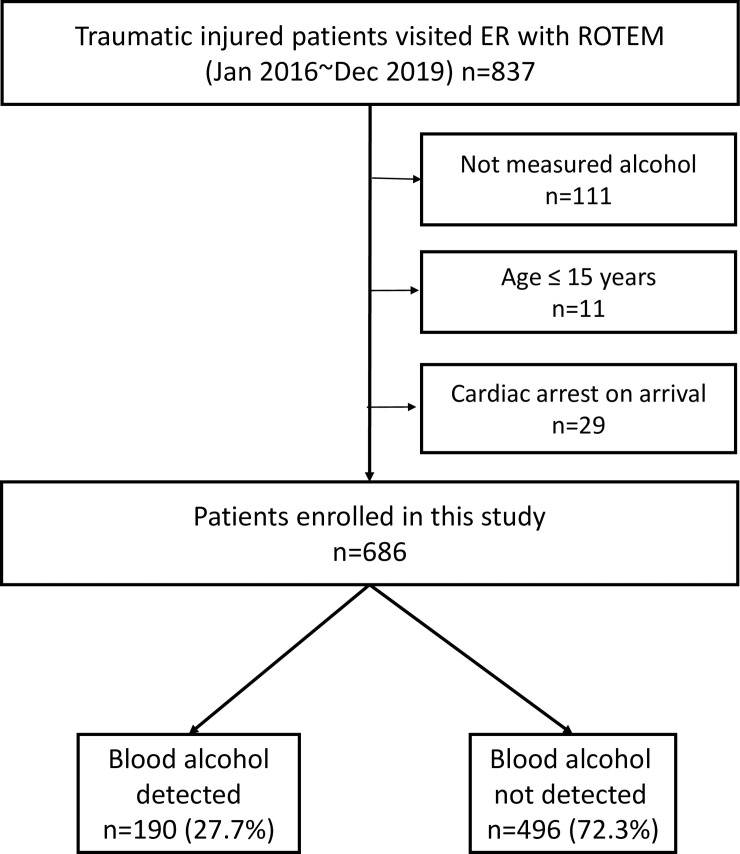
Flow chart of enrolled patients in this study.